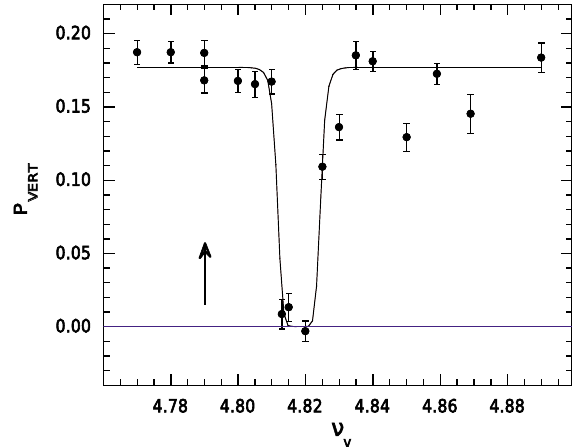
FIG. 2. (Color) The measured vertical proton polarization at 202.7 MeV is plotted against the vertical betatron tune. The curve is hand drawn to guide the eye. For the later studies, we set n y at the arrow value of 4.791, which is well away from the n s (cid:1) 7 2 n y resonance